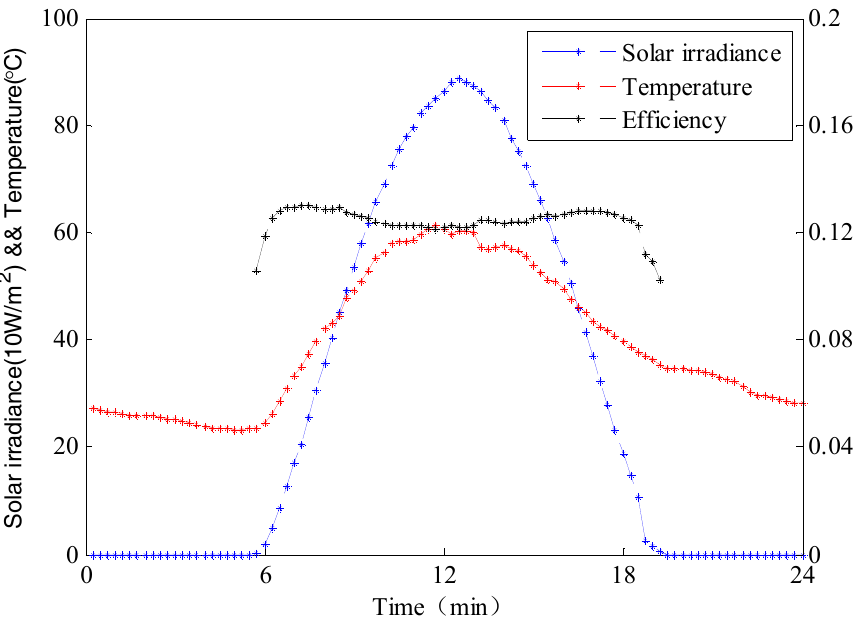
Figure 4. Efficiency characteristics of silicon-based PV modules at different temperatures and irradiance conditions.